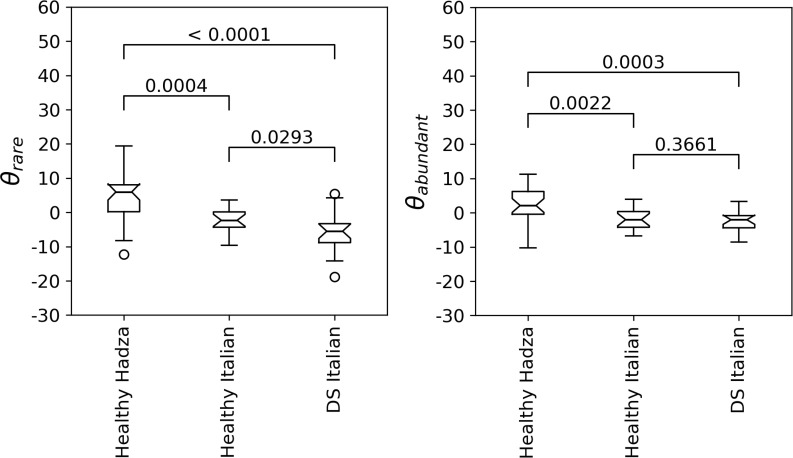
GM biodiversity and health status.Box-plots representing the distribution of GM biodiversity (θrare on the left and θabundant on the right) in the three groups of Healhty Hadza, Healthy Italian controls and DS Italian subjects. Mann-Whitney U-test p-values are reported for each pairwise comparison. Both biodiversity indices were adjusted for the total number of reads before computing the box-plots and hypothesis tests.